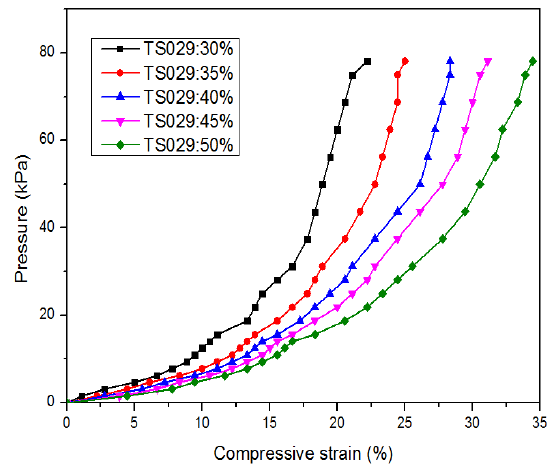
Figure 8. The compressive strain of the pressure sensors as a function of the applied pressure.